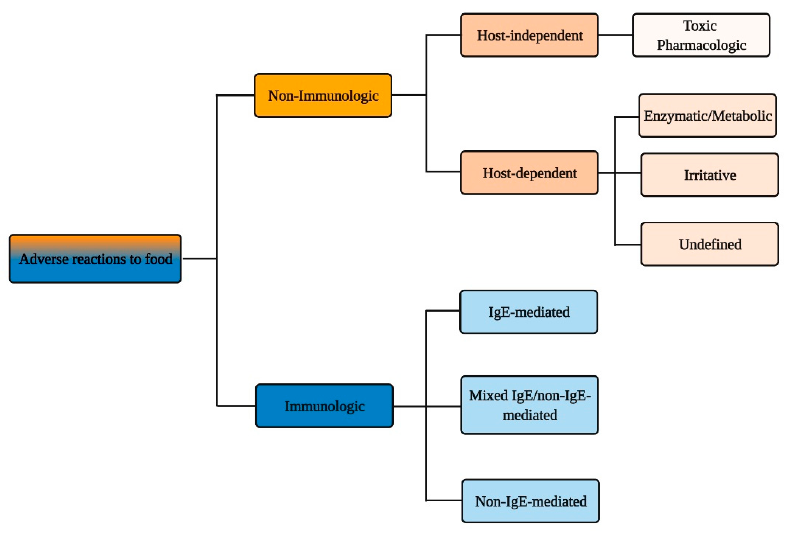
Figure 1. Immunologic vs. non-immunologic adverse reactions to food.